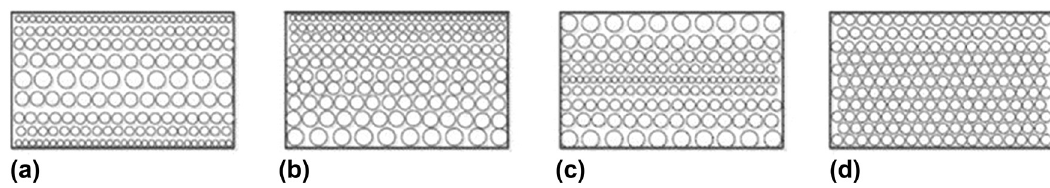
Figure 5: Distinctive porosity distributions of functionally graded porous graphene platelet reinforced nanocomposites ( FGP - GLPRC ) in di ff erent styles [ 26 ] .